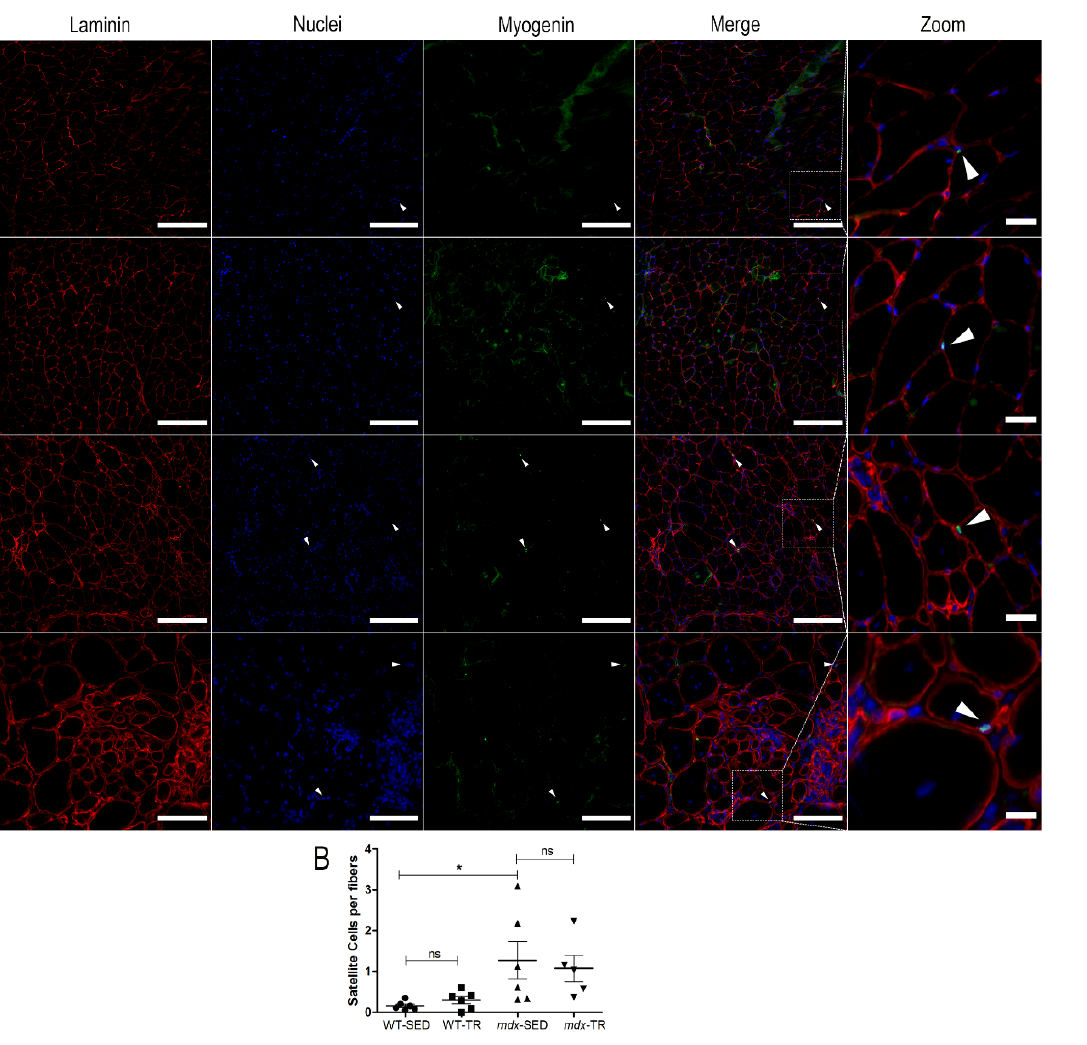
cells through the Pax7 antibody. Laminin (red, Cy5), nuclei (blue, DAPI), and Pax7 (green, FITC) are shown. White arrows: Indication of SCs (Pax7 + underlying nuclei). Images were obtained with the ImageXpress XLS System microscope at 40 × magnification. Scale bar = 100 µ m (laminin, nuclei, Pax7 and merged panels). All zoomed areas provided better visualization of the SCs (scale bar = 20 µ m). SCs were identified by their localization below the laminin superimposed with the nuclei. ( B ) As expected, the WT-SED group had few quiescent/activated SCs when compared to the mdx -SED group. After a low-intensity training for 37 sessions, the mdx -TR group showed increased